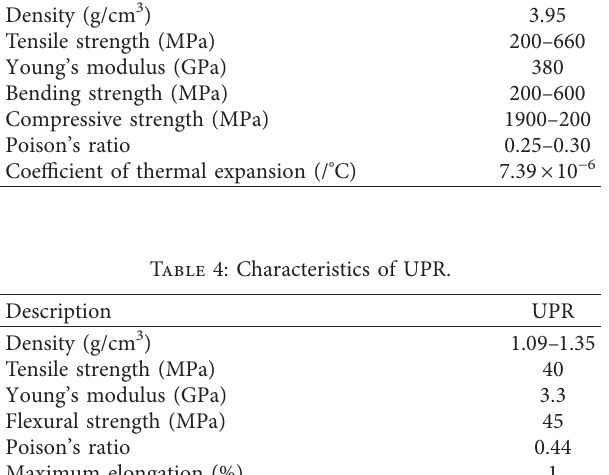
Table 3: Characteristics of Al